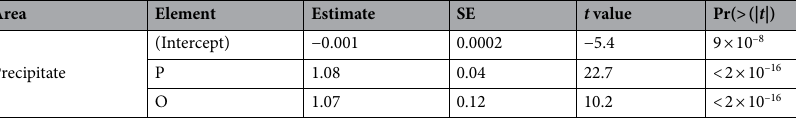
Table 3. Model 2 multivariable linear regression.* *Model 2 was Gd ~ P + O (using intracellular precipitates only). Residuals (minimum, median, and maximum) for precipitate were −0.007, −0.0006, and 0.016. Residual standard error was 0.003 on 2270 degrees of freedom, multiple r 2 0.27, adjusted r 2 0.27, F -statistic 413.8 on 2 and 2270 degrees of freedom, P < 2.2 × 10 –16 . The Akaike information criterion for Model 2 was